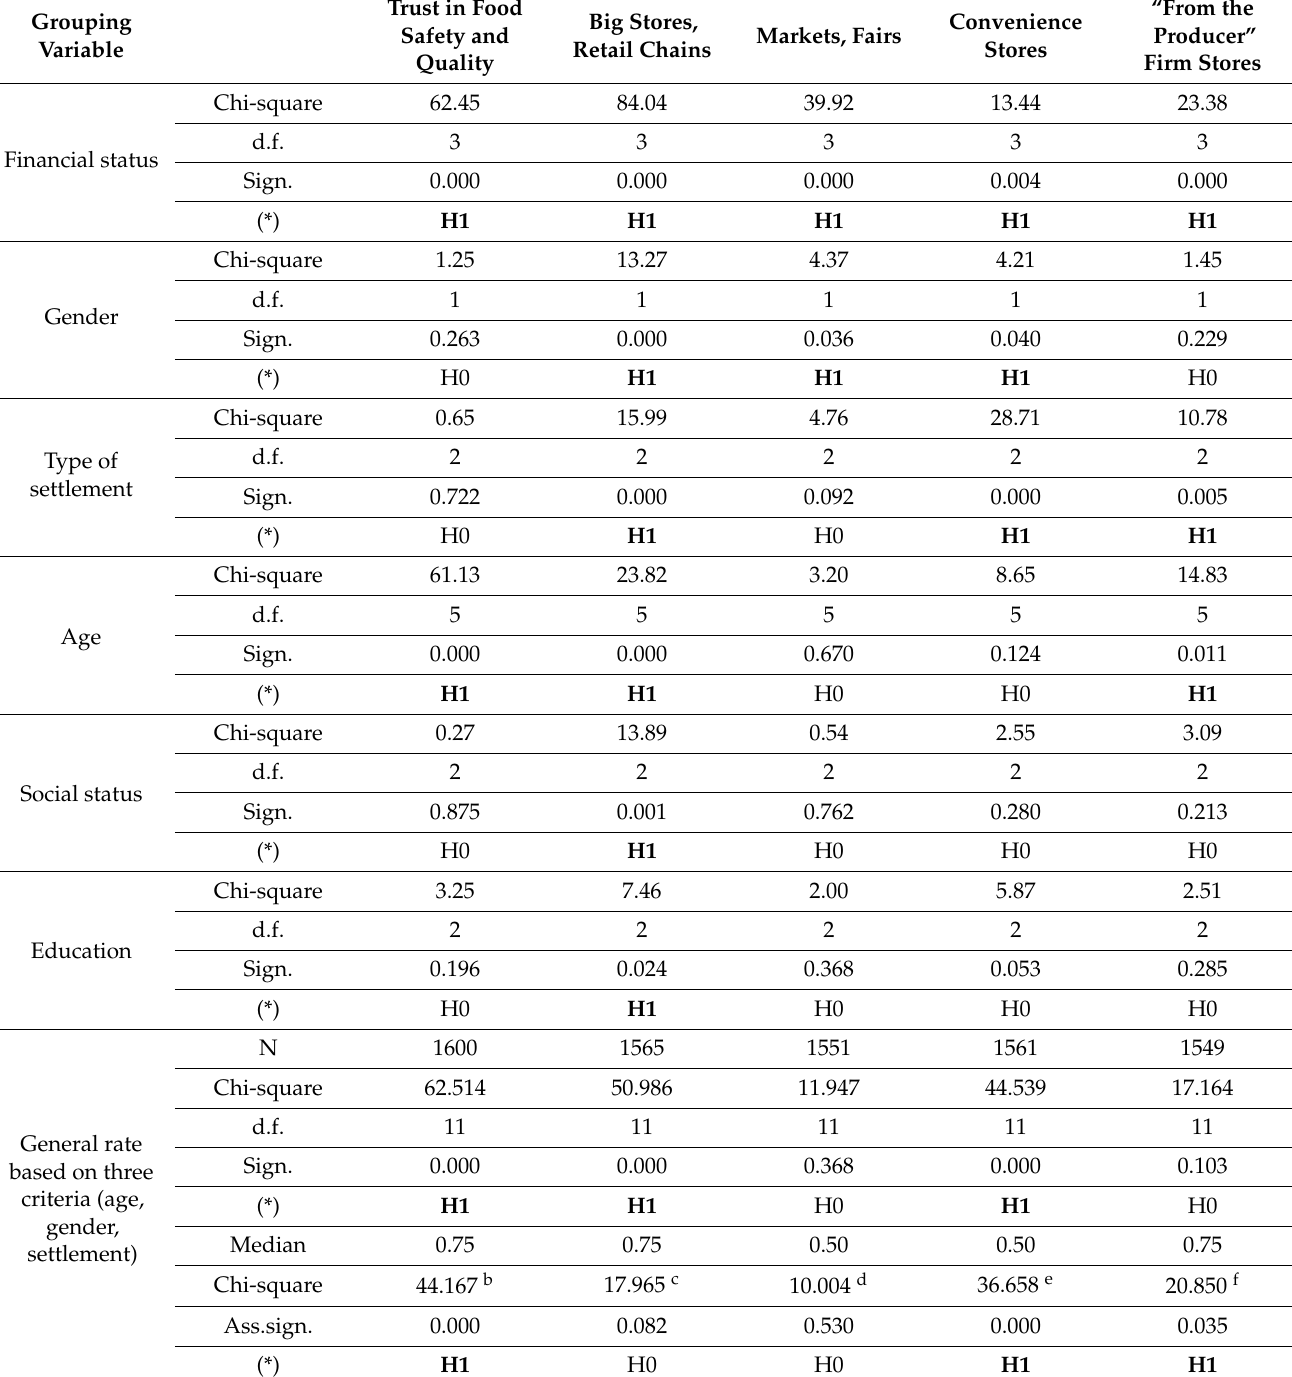
Table 2. Nonparametric tests (Kruskal–Wallis) verifying differences in the level of trust in food quality and safety for different